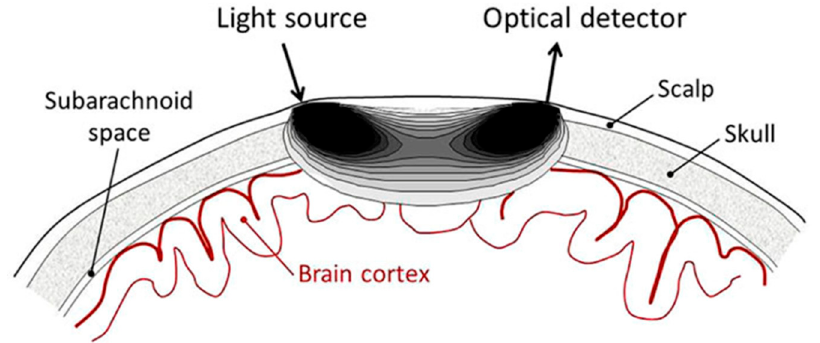
Figure 1. Schematic representation of the optical region of sensitivity (banana-shaped shaded area) in non-invasive near-infrared (NIR) studies of the human brain. The illumination and collection points (which are coupled to a light source and optical detector, respectively) are located on the scalp at a relative distance of the order of 3 cm. Light propagation is affected by the heterogeneity in the optical properties of tissues. Therefore, the sensitivity of the optical signal to the probed tissue is not spatially uniform (as indicated by the different grey levels within the region of sensitivity) and is maximal in the most superficial tissue layers (scalp and skull). Reproduced with permission from [5] © 2018 licensed under a Creative Commons Attribution (CC BY) license.